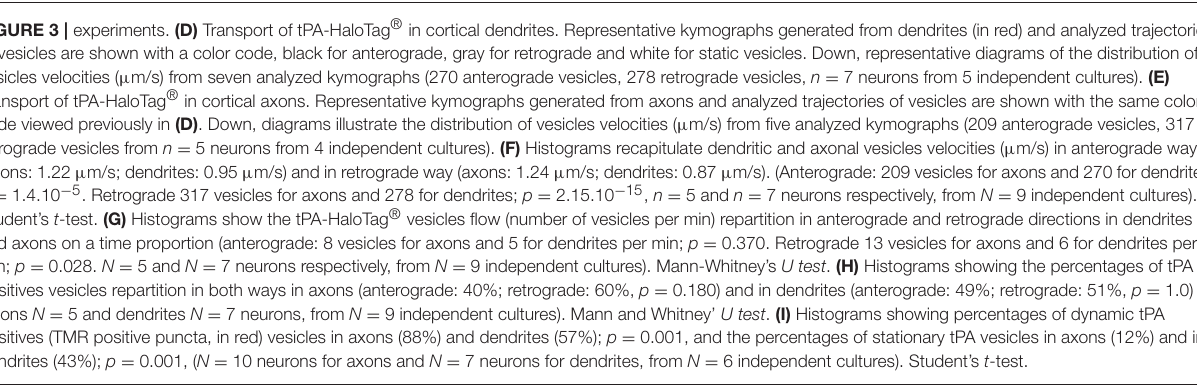
FIGURE 3 | experiments. (D) Transport of tPA-HaloTag ® in cortical dendrites. Representative kymographs generated from dendrites (in red) and analyzed trajectories of vesicles are shown with a color code, black for anterograde, gray for retrograde and white for static vesicles. Down, representative diagrams of the distribution of vesicles velocities ( µ m/s) from seven analyzed kymographs (270 anterograde vesicles, 278 retrograde vesicles, n = 7 neurons from 5 independent cultures). (E) Transport of tPA-HaloTag ® in cortical axons. Representative kymographs generated from axons and analyzed trajectories of vesicles are shown with the same color code viewed previously in (D) . Down, diagrams illustrate the distribution of vesicles velocities ( µ m/s) from five analyzed kymographs (209 anterograde vesicles, 317 retrograde vesicles from n = 5 neurons from 4 independent cultures). (F) Histograms recapitulate dendritic and axonal vesicles velocities ( µ m/s) in anterograde way (axons: 1.22 µ m/s; dendrites: 0.95 µ m/s) and in retrograde way (axons: 1.24 µ m/s; dendrites: 0.87 µ m/s). (Anterograde: 209 vesicles for axons and 270 for dendrites; p = 1.4.10 − 5 . Retrograde 317 vesicles for axons and 278 for dendrites; p = 2.15.10 − 15 , n = 5 and n = 7 neurons respectively, from N = 9 independent cultures). Student’s t -test. (G) Histograms show the tPA-HaloTag ® vesicles flow (number of vesicles per min) repartition in anterograde and retrograde directions in dendrites and axons on a time proportion (anterograde: 8 vesicles for axons and 5 for dendrites per min; p = 0.370. Retrograde 13 vesicles for axons and 6 for dendrites per min; p = 0.028. N = 5 and N = 7 neurons respectively, from N = 9 independent cultures). Mann-Whitney’s U test . (H) Histograms showing the percentages of tPA positives vesicles repartition in both ways in axons (anterograde: 40%; retrograde: 60%, p = 0.180) and in dendrites (anterograde: 49%; retrograde: 51%, p = 1.0) (axons N = 5 and dendrites N = 7 neurons, from N = 9 independent cultures). Mann and Whitney’ U test . (I) Histograms showing percentages of dynamic tPA positives (TMR positive puncta, in red) vesicles in axons (88%) and dendrites (57%); p = 0.001, and the percentages of stationary tPA vesicles in axons (12%) and in dendrites (43%); p = 0.001, ( N = 10 neurons for axons and N = 7 neurons for dendrites, from N = 6 independent cultures). Student’s t